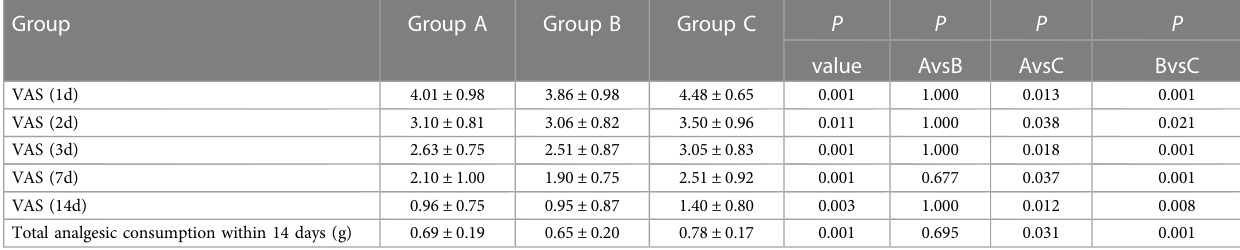
TABLE 2 Comparison of postoperative visual analog scale (VAS) for pain and total analgesic consumption over 14 days among three groups. Group